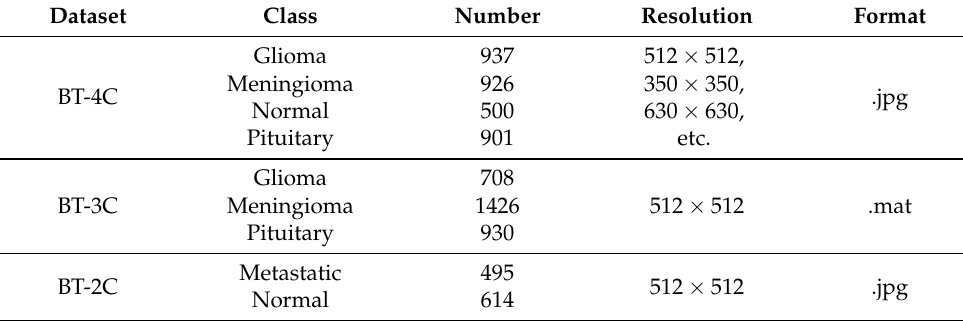
Table 2. The main characteristics of the three